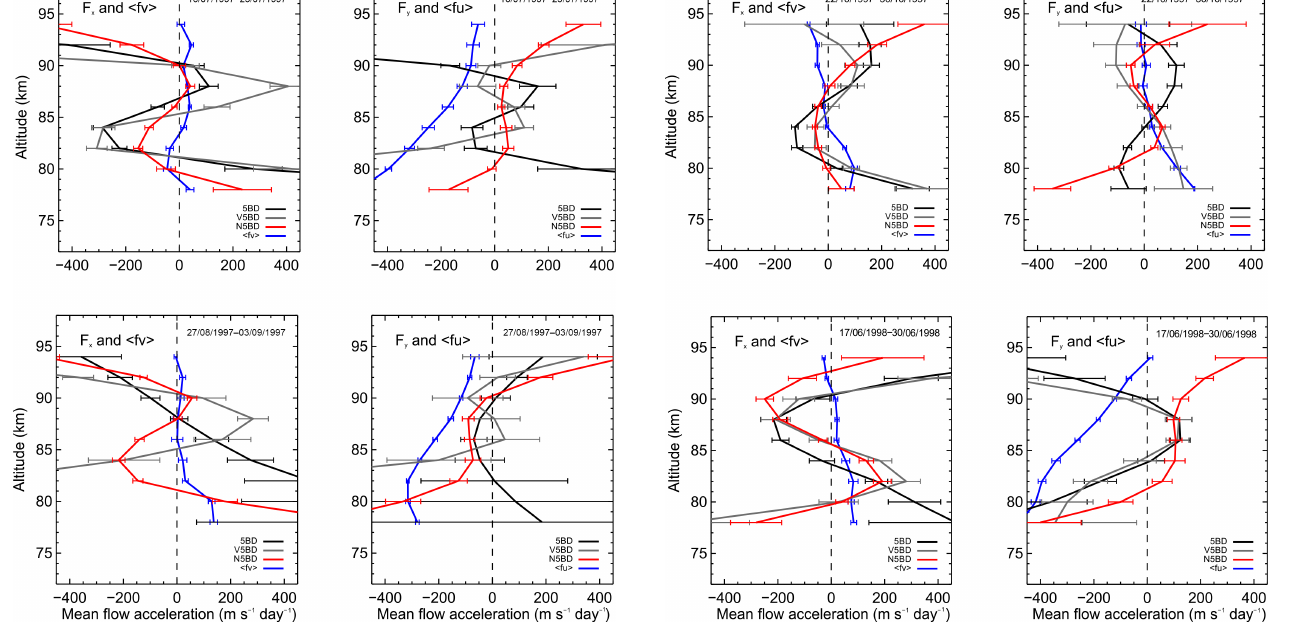
Figure 12. Vertical profiles of the zonal and meridional body forces (determined by three independent techniques) and corresponding accelerations due to Coriolis torques, obtained from the July 1997 (upper panels) and September 1997 (lower panels) campaigns.